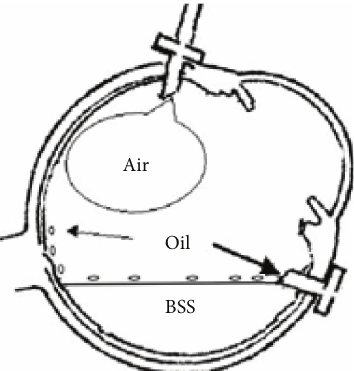
Figure 4: The emulsified silicone oil droplets adhering to the retinal surface would be pushed into the vitreous cavity, while the air entered into the vitreous cavity. The silicone oil droplets would float up because of buoyancy and finally form a thin oil layer between the air (upper layer) and the balanced salt solution (BSS, bottom layer). At that time, the patient’s head was gradually turned temporally by approximately 90 ∘ , so that the silicone oil layer together with BSS would flow out of the eyeball through the inferior-temporal cannula due to